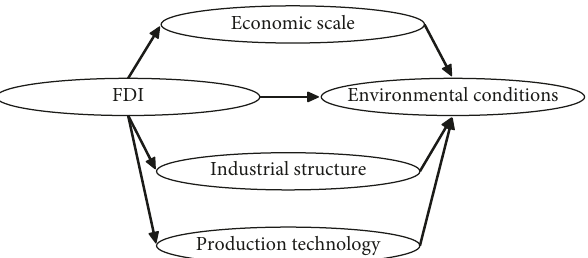
Figure 1: The action mechanisms of FDI’s environmental effects on the host